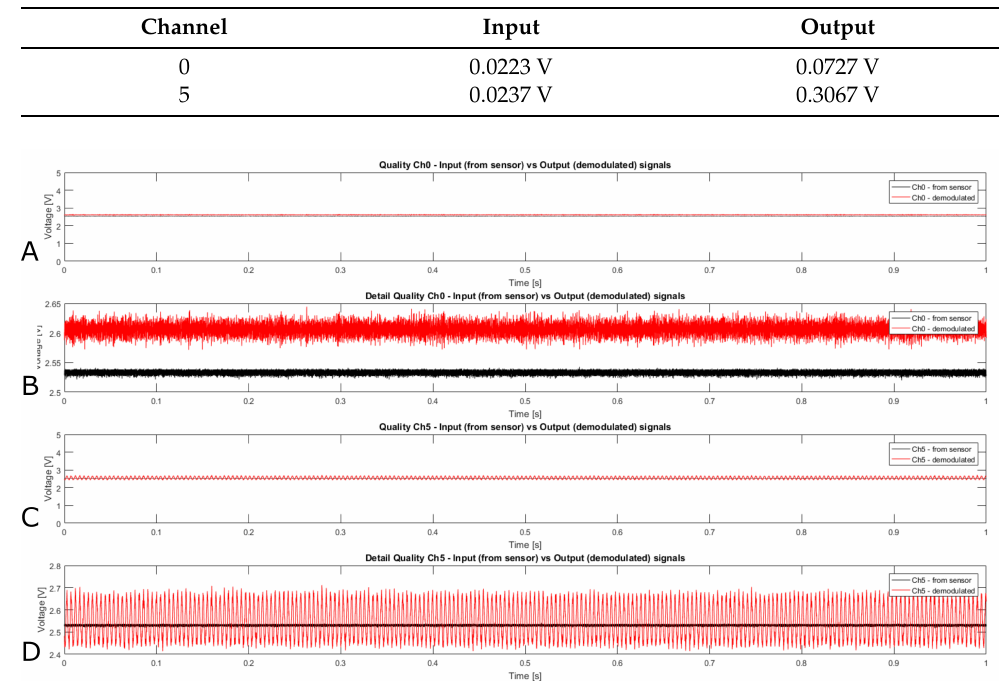
Table 2. Signal noise amplitude.